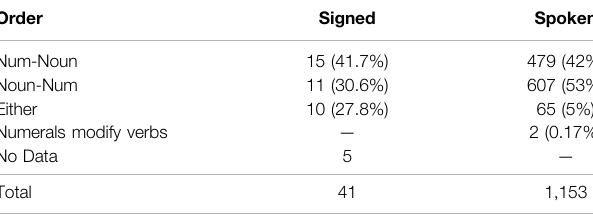
TABLE 4 | Noun/numeral order in signed and spoken